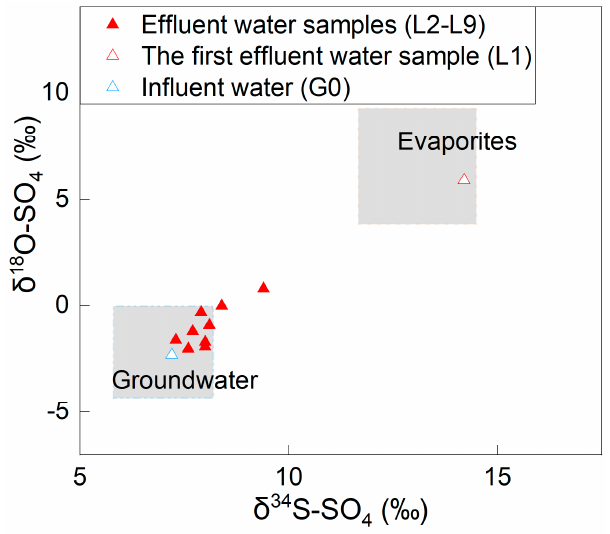
Figure 3. Sulfur and oxygen isotope distribution in the effluent water (the ranges of the δ 34 S-SO 4 and δ 18 O-SO 4 values of SO 4 -containing evaporites and groundwater were adopted from Long et al. [21].